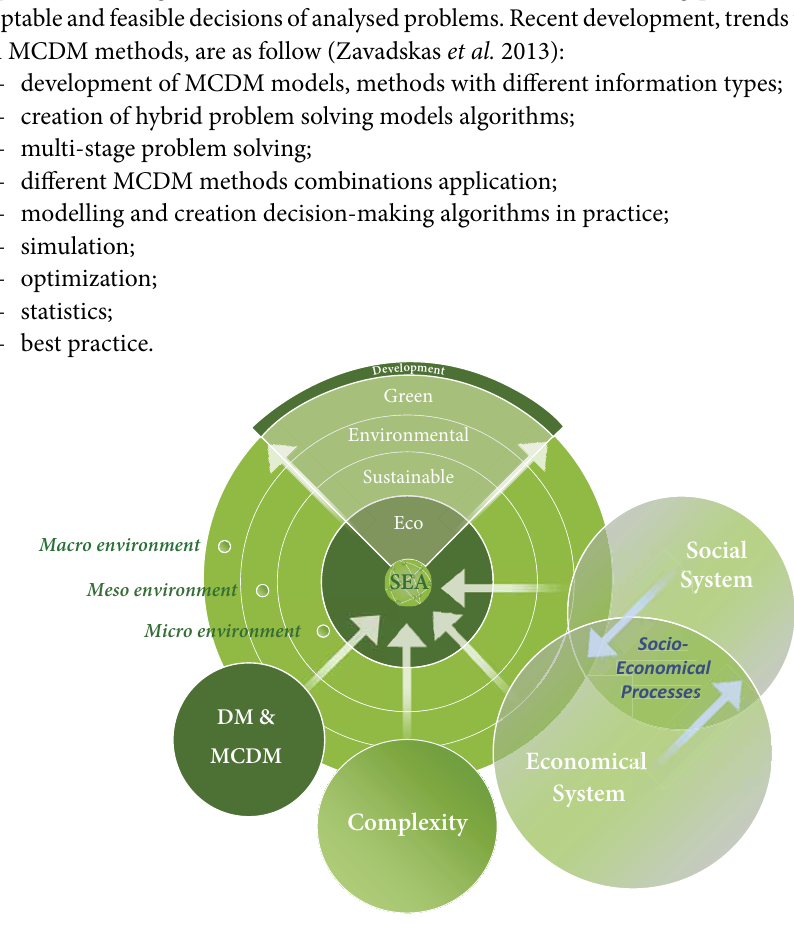
Fig. 2. Quantitative Complex evaluation of Strategic Environmental